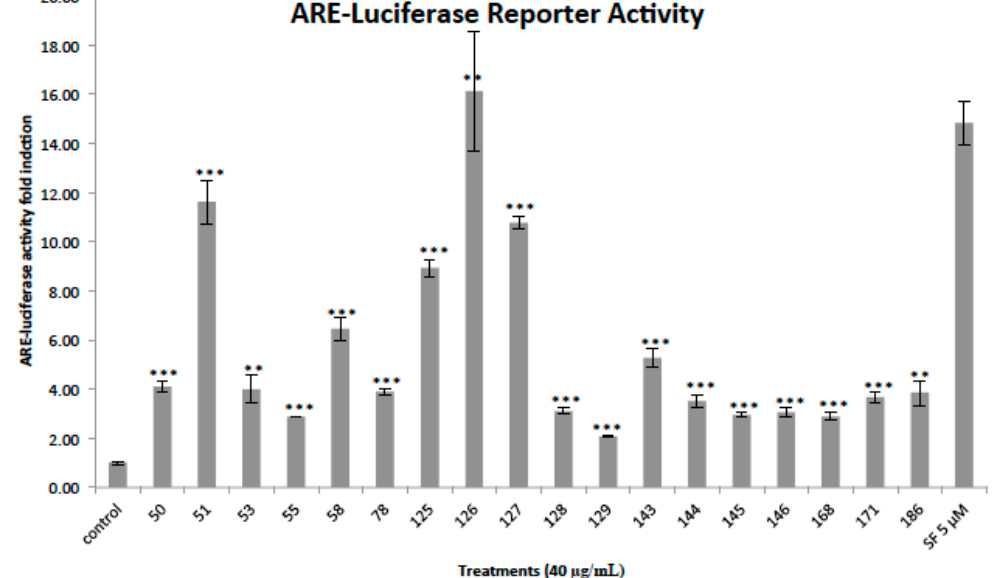
Figure 5. The e ff ect of pure compounds on ARE-luciferase reporter activity in ARE repoter-HepG2 cells. Cells were seeded in 96-well plates at a density of 4 × 10 4 cells / well and incubated for 24 h. The cells were further treated with compounds (40 µ g / mL each) for additional 24 h. The negative control cells were treated with 0.2% DMSO, and positive control cells were treated with 5 µ M DL-sulforaphane (SF). Luciferase activity were determined. Mean ARE-luciferase reporter activity represents the average of three-independent experiments ± S.E.M. ** p < 0.01, *** p < 0.001. Table 4. Relative Nrf2 activity induced by compounds (40 μ g/mL) isolated from Jing liqueur.